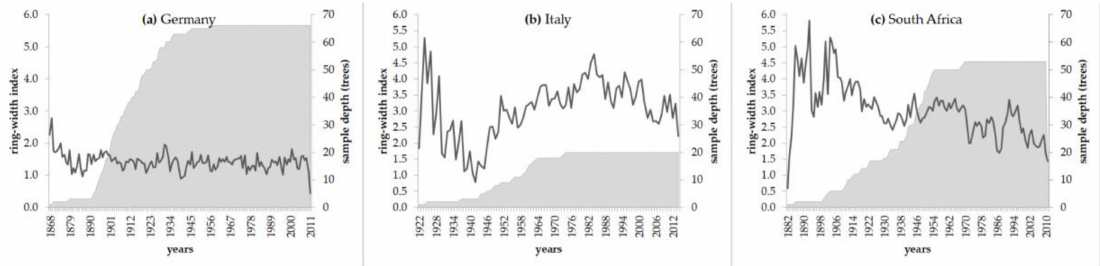
Figure 3. Ring-widthchronologiesofthethreedifferentexperiments: ( a )Germany,( b )Italy,and( c )SouthAfrica. The dark grey graph represents the averaged raw value chronologies of each experiment’s sites. On the second Y -axis, the sample depth is pictured as an